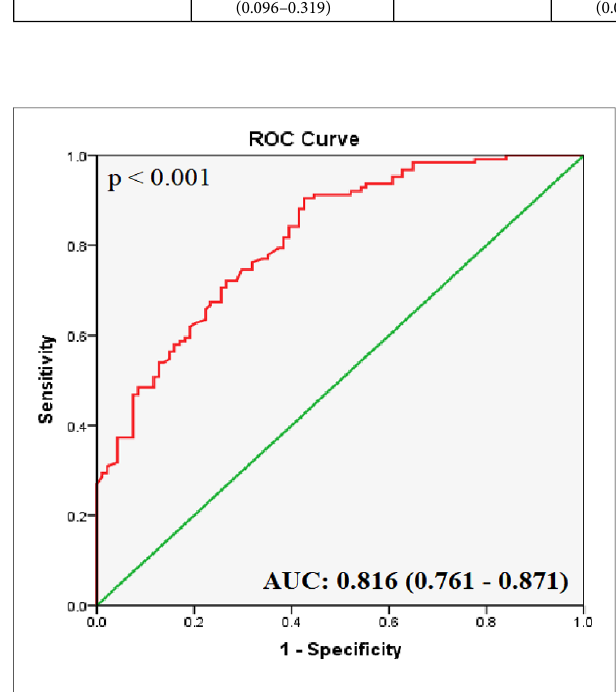
FIGURE 2 ROC curve analysis of hsa_circ_0001445. The AUC shows the diagnostic ability of hsa_circ_0001445 in terms of CHD ( p <0.001).